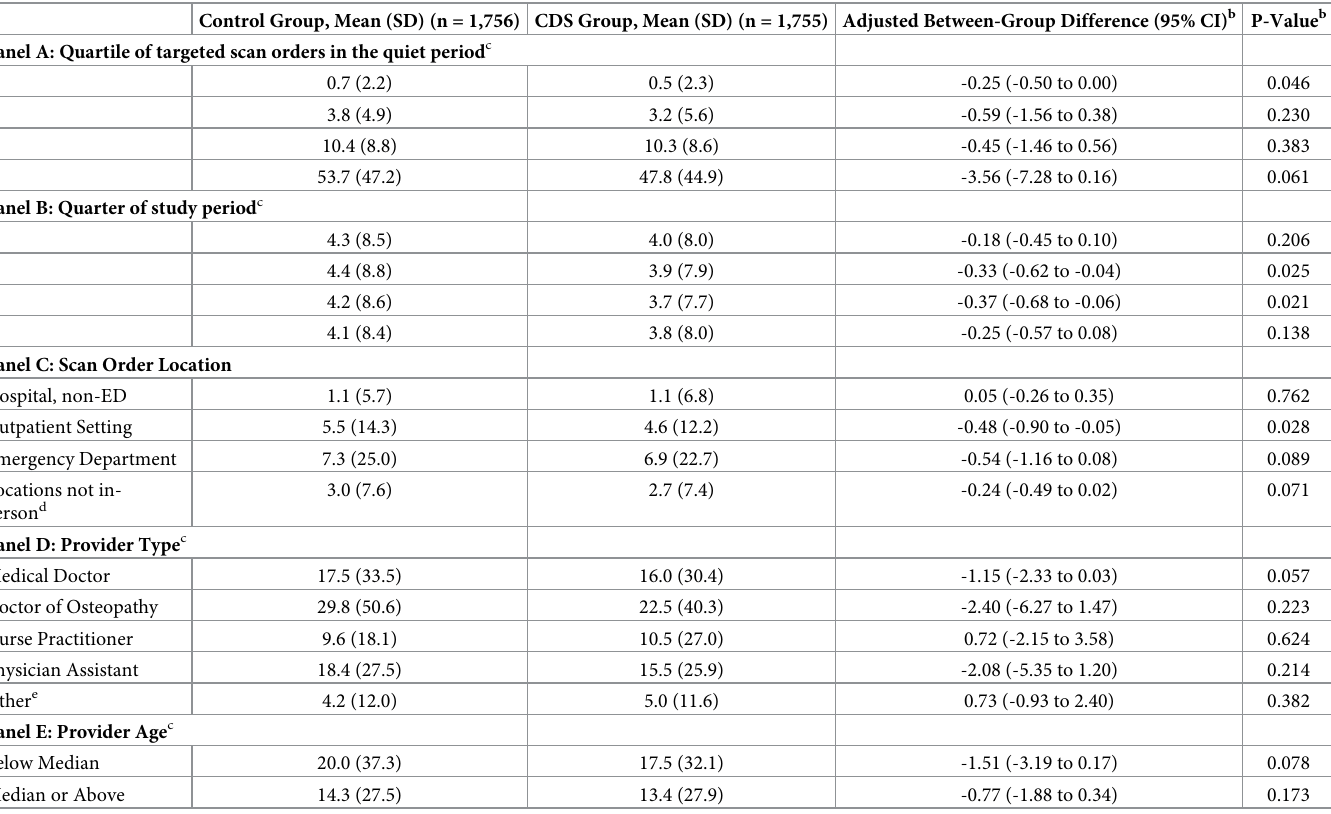
Table 3. Subgroup analysis of impact of CDS on targeted scans a